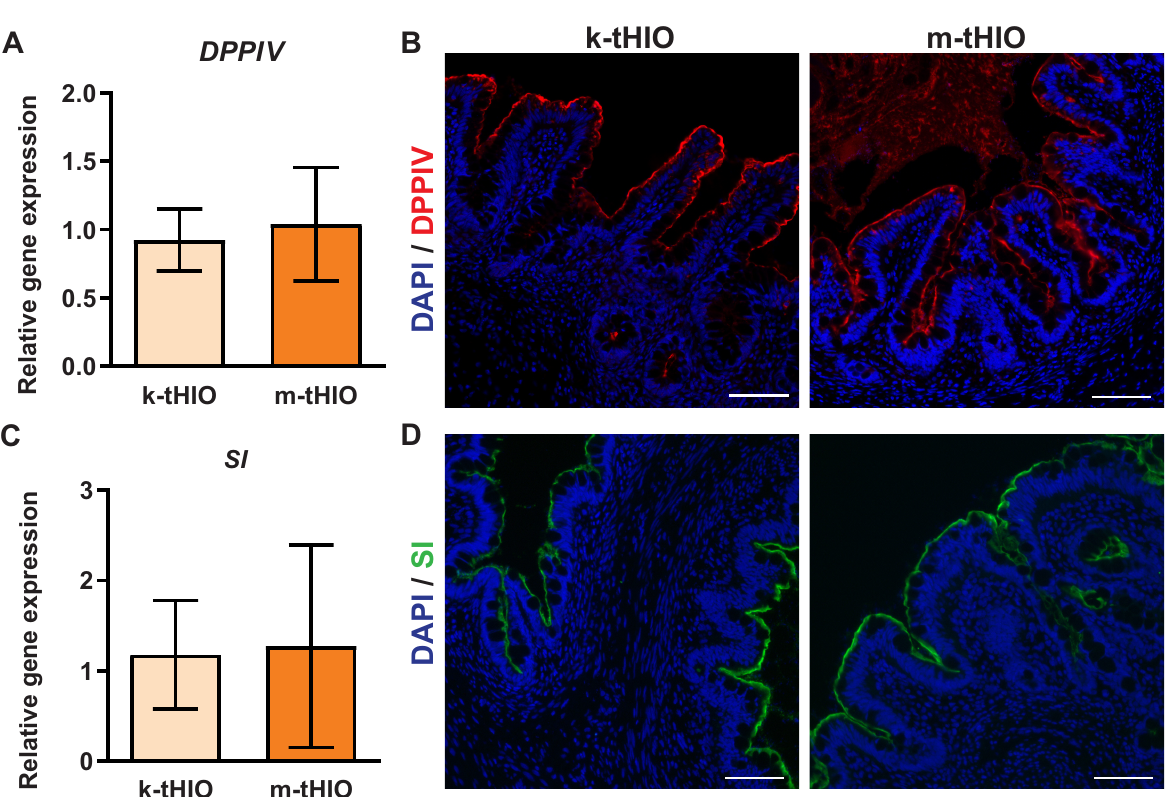
Fig 5. Grafts harvested from both sites expressed markers of carbohydrate digestion. (A) Relative gene expression of DPPIV in k-tHIO and m- tHIO. (B) Protein level expression, by immunofluorescence, in k-tHIO and m-tHIO associated to transcripts in A. Scale bars = 50 μ m. (C) Relative gene expression of SI in k-tHIO and m-tHIO. (D) Protein level expression, by immunofluorescence, in k-tHIO and m-tHIO associated to transcripts in C. Scale bars = 50 μ m. (A, C) For k-tHIO, n = 7 and for m-tHIO n = 5; p = n.s. for both.